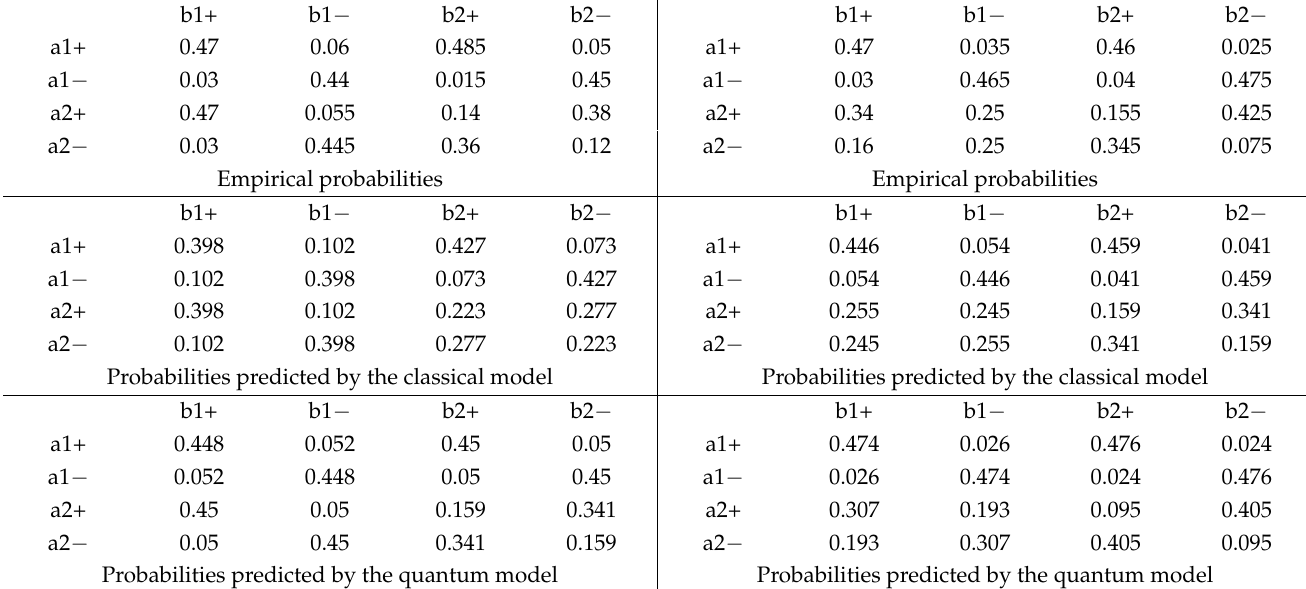
Table 9. The observed and fitted results for Experiments 1 (left) and 2